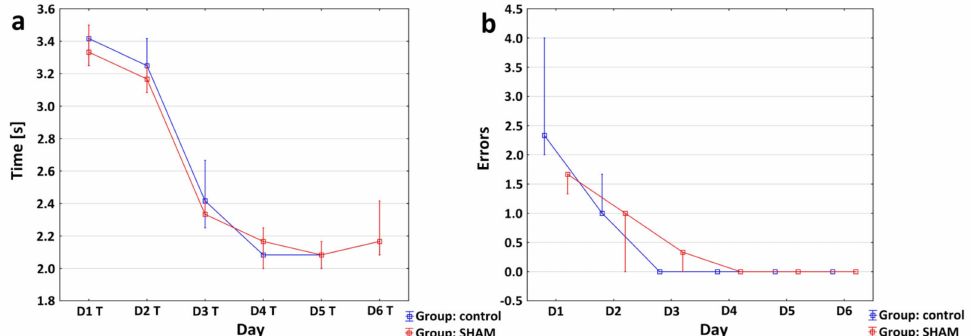
Figure 5. The validation process between the SHAM and Control Group with the use of the motor test; ( a ) the graph shows the median +/ − IQR of the average time taken by control and SHAM rats to cross theslat. The Mann–Whitney U test shows no statistically significant differences in the mean time of rats’ crossing the slat between the Control Group and the SHAM Group on each of the days of the experiment ( p > 0.16); ( b ) the graph shows the median +/ − IQR of the number of errors (collectively for four paws) made by the rats on consecutive days of the training (D1–D5) and on D6 in the SHAM and Control Group. Friedman ANOVA for the Control Group: χ 2 ( N = 3, df = 5) = 15.00000, p = 0.01036; for the SHAM group: χ 2 ( N = 3, df = 5) = 12.92208, p = 0.02412. The Mann–Whitney U test shows no statistically significant differences in the mean number of errors made by rats between the Control and SHAM Group on each of the days of the experiment ( p ≥